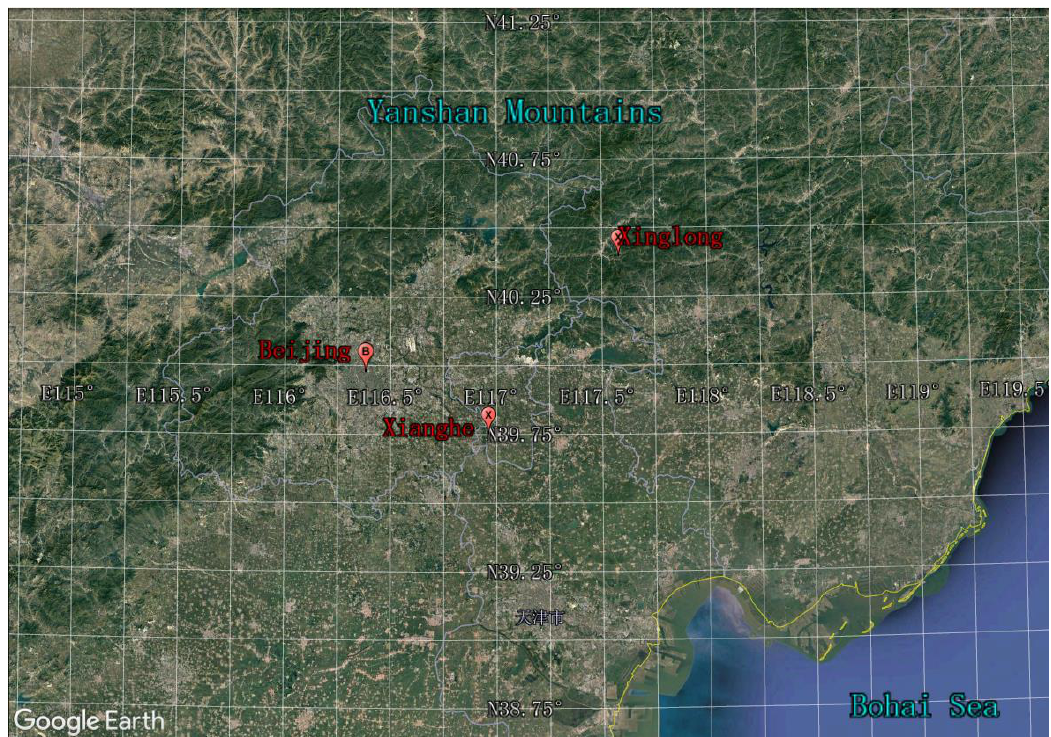
Figure 1. Google Earth map of the three AERONET (AErosol RObotic NETwork) sites: urban Beijing (BJ: 39.98°N, 116.38°E, 92.0 m above sea level), suburban Xianghe (XH: 39.75°N, 116.96°E, 36.0 m ASL), and rural Xinglong (XL: 40.40°N, 117.58°E, 920.0 m ASL). Xianghe (XH: 39.75°N, 116.96°E, 36.0 m ASL), with a population of 350,000, is a county in the